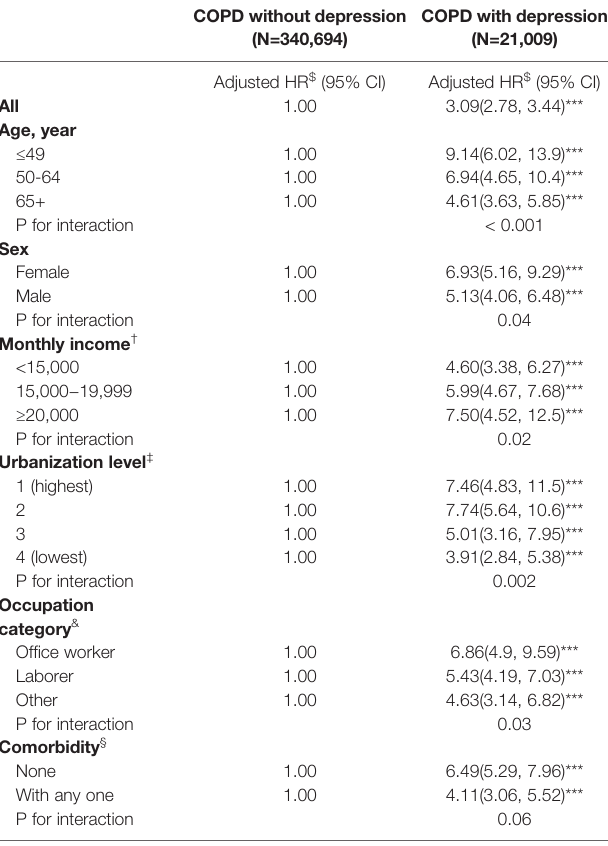
TABLE 3 | Comparison of incidence and hazard ratio of suicide attempt strati fi ed based on age, sex, and comorbidities between copd patients with and without